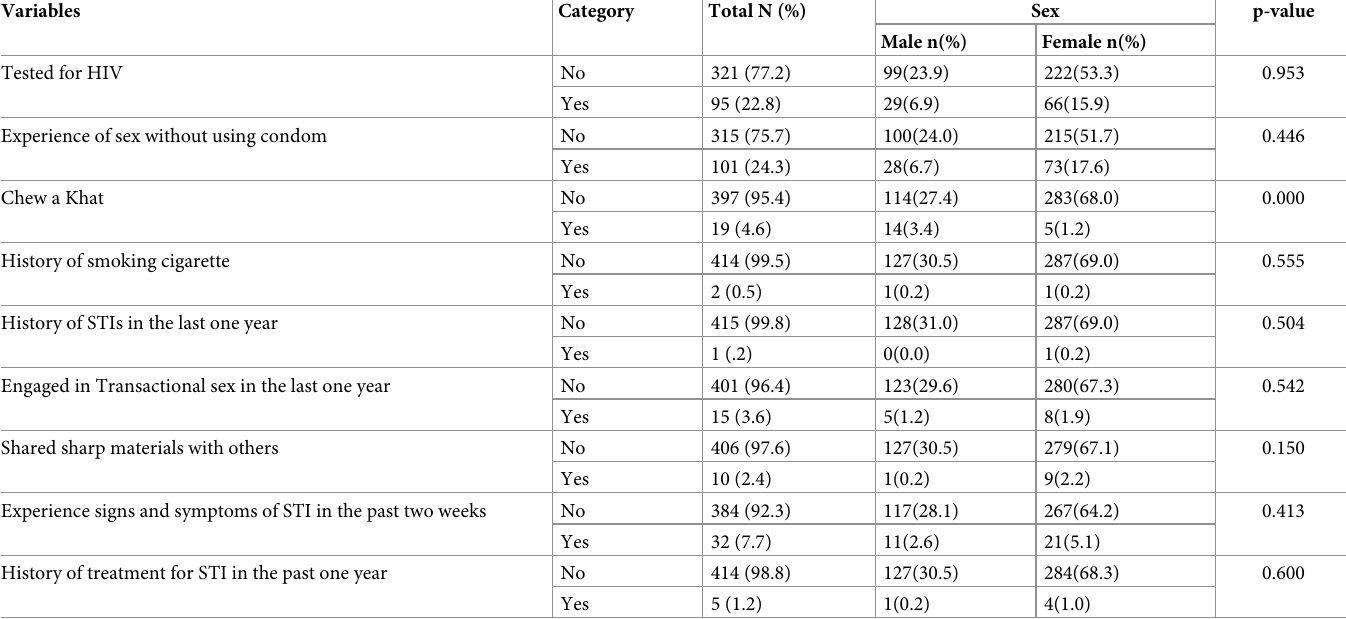
Table 3. Behavior-related characteristics of youth-friendly services Attendees at selected health facilities in Hawassa city, Sidama Regional State, Ethiopia, May 1 to August 30, 2021 (N = 416). Variables